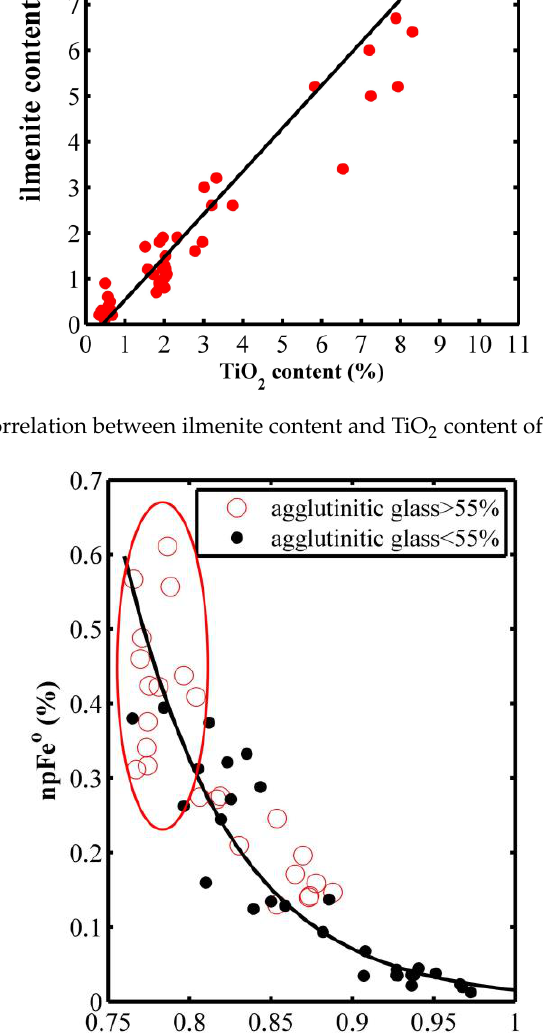
Figure 11. Correlation between the ratio of 540 nm SSA/810 nm SSA and npFe 0 for ( a ) lunar soil samples with agglutinitic glass content < 55% and for ( b ) lunar soil samples with agglutinitic glass content > 55%. 5.2. Non-linear Correlation Analysis Figure 4 shows that the correlation between npFe 0 and the ratio of 540 nm SSA /810 nm SSA can be regressed using an exponential function rather than a linear function. One reason might be that higher agglutinitic glass content within lunar soils, as discussed in Section 5.1, could result in the unsensitivity of the 540 nm/ 810 nm SSA ratio to the variation of npFe 0 abundance. This can be demonstrated by the fact that a relatively acceptable linear relationship (R 2 = 0.82) exists between soil samples of lower agglutinitic glass content and npFe 0 abundance when soil samples of higher agglutinitic glass content were ignored (Figure 12a). Alternatively, it was found that if sub-mature soil samples were not considered, the correlation between npFe 0 and the ratio of 540